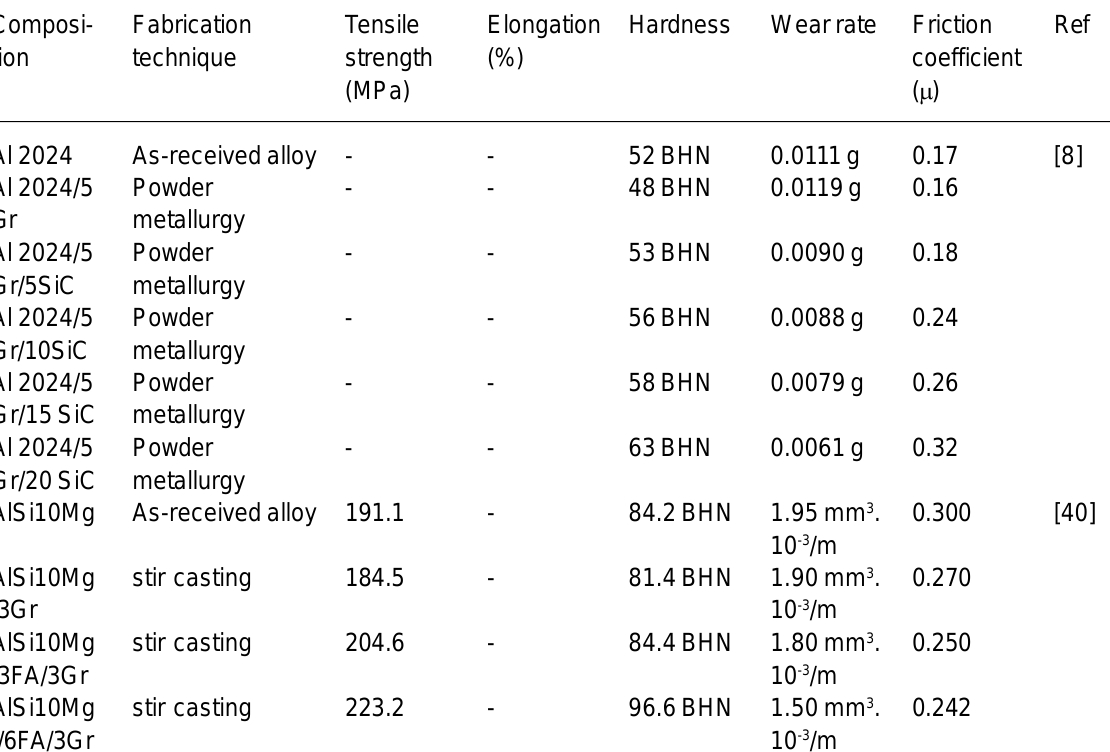
Table 3. The mechanical and tribological properties of aluminum and magnesium based self-lubricating hybrid composites reinforced with and without graphite